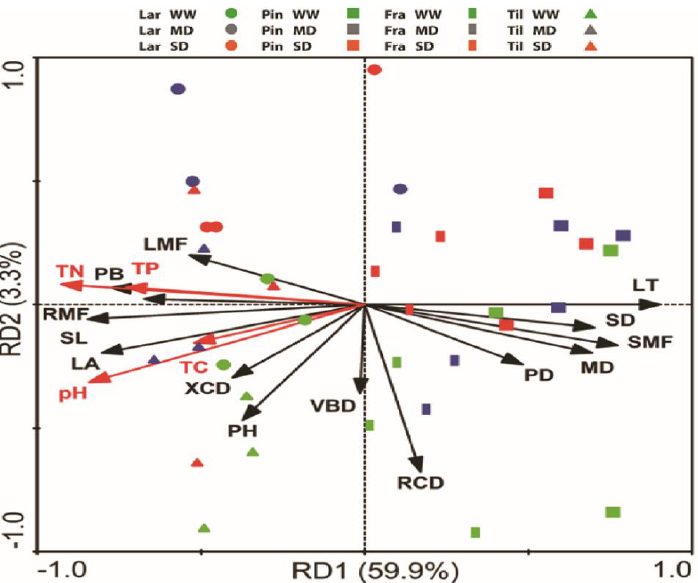
Figure 5. Redundancy analysis (RDA) of morpho-functional plant traits to the soil-related parame- ters, i.e., soil pH, TN, TC, and TP taken from 0 – 20 cm soil depth in northeast China. Abbreviations, thickness; LA: leaf area; XCD: xylem conduit diameter; VBD: vascular bundle diameter; SL: stomata pore length; SD: stomatal density; PB: plant biomass; PH: plant height; RCD: root collar diameter; RMF: root mass fraction; SMF: stem mass fraction; LMF: leaf mass fraction; PD: stem water potential at predawn; MD: stem water potential at midday; pH: soil pH; TN: total nitrogen; TC: total carbon; TP: total